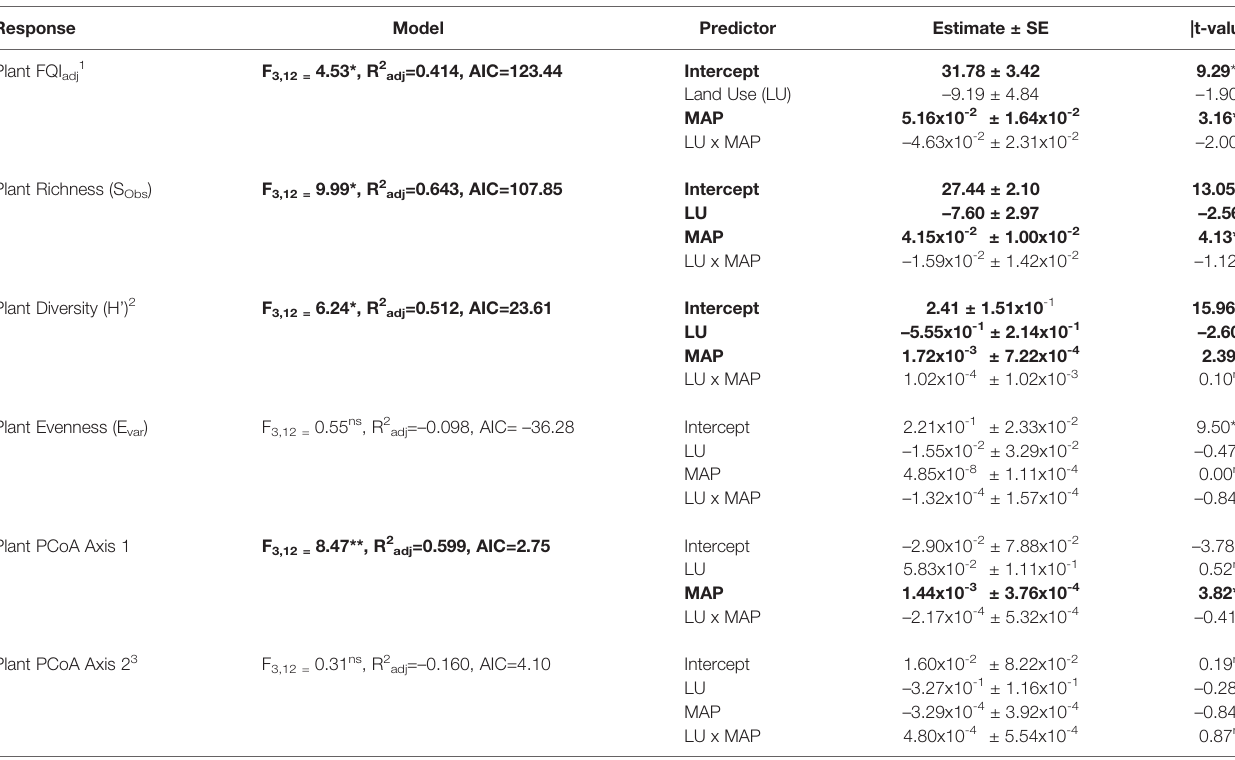
TABLE 2 | Multiple linear regression model statistics for plant community diversity, richness, evenness, and compositional estimates predicted by land use history (LU) and mean annual precipitation (MAP) normalized around the mean precipitation (730.01 mm yr -1 ) main effects and their interaction (LU x MAP) with native prairie remnants as reference (0) compared to post-agricultural sites